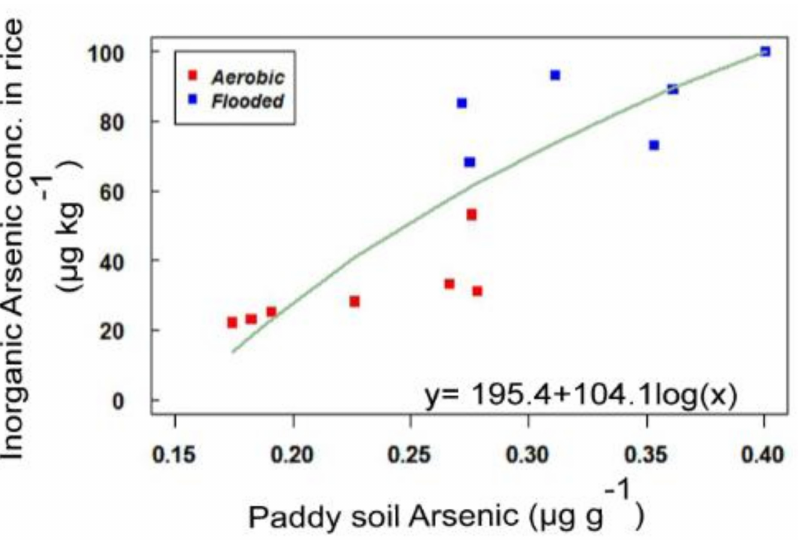
Figure 3. Relationship between paddy soil As and inorganic As concentrations in rice grain. As (III) was the dominant inorganic species in both of the water regimes. Rice plants usually take up As (III) from the soil with a higher magnitude compared to As (V) [50]. Accumulation of As (III) might be enhanced by the direct absorption of pore water in the rhizosphere system and the consequent transport into grain under flooded treatment compared to aerobic condition. Regression analyses of total As against inorganic As species across the treatments of amendment and water regime explained the satisfactory level of variation with the significantly positive relationship having a higher slope of As (III) (Figure 4). This consequence suggests the higher translocation of As (III) in rice compared to As